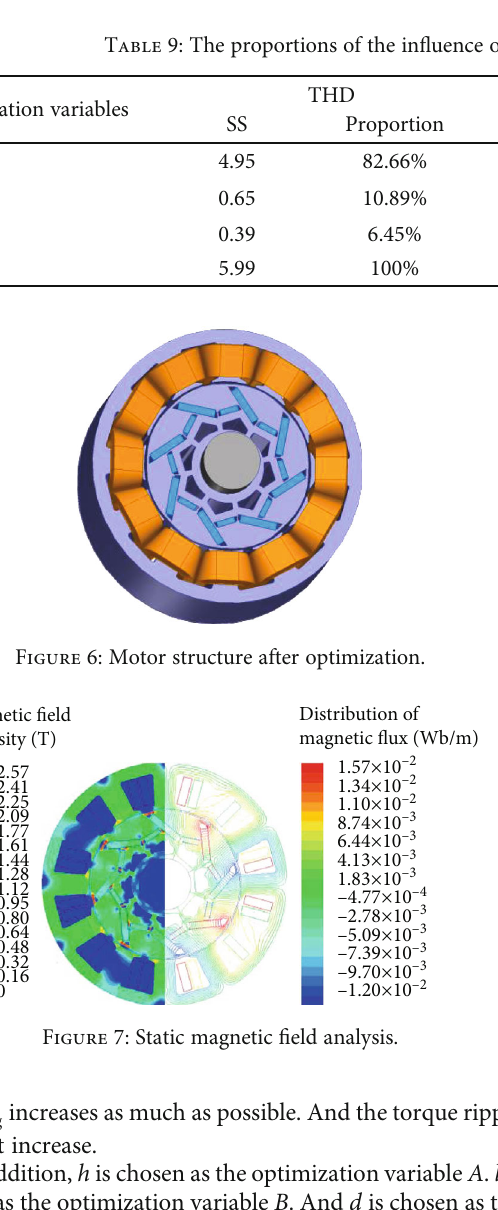
Figure 8: Air-gap fl ux density waveform and harmonic analysis: (a) before optimization; (b) after